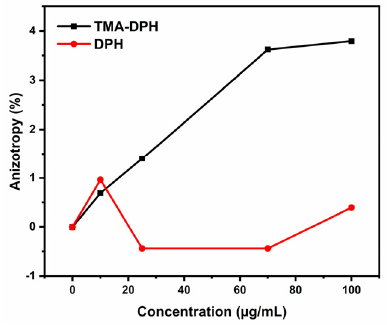
Figure 9. Changes in anisotropy of the membrane probes (TMA − DPH and DPH).